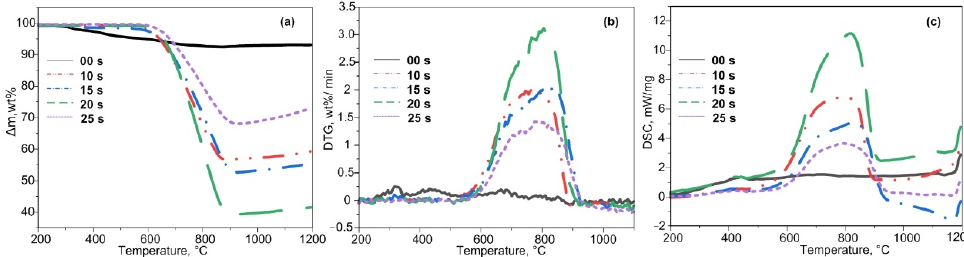
Figure 2. TG ( a ), DTG ( b ), and DSC ( c ) curves for oxidation of the initial ash and that processed in